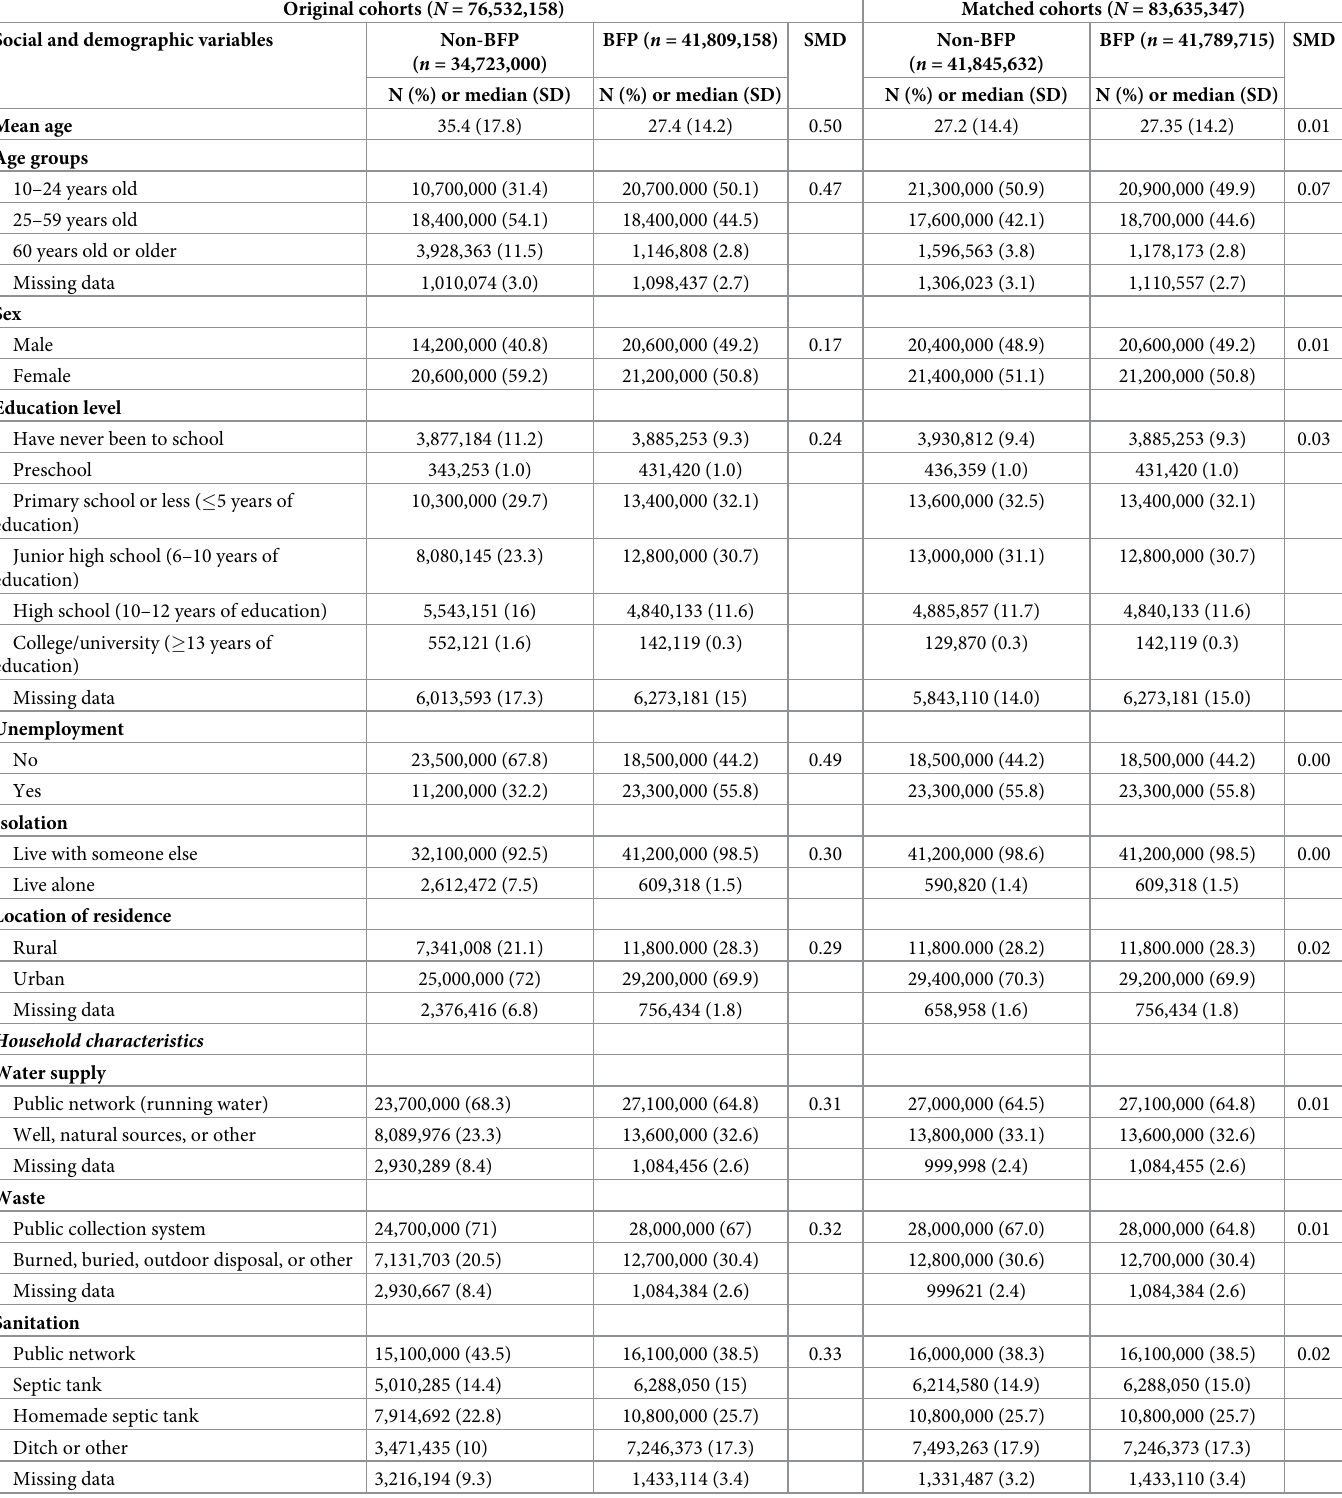
Table 1. Description of nonbeneficiaries (non-BFP) and beneficiaries of the BFP in the original and matched cohorts from 2004 to